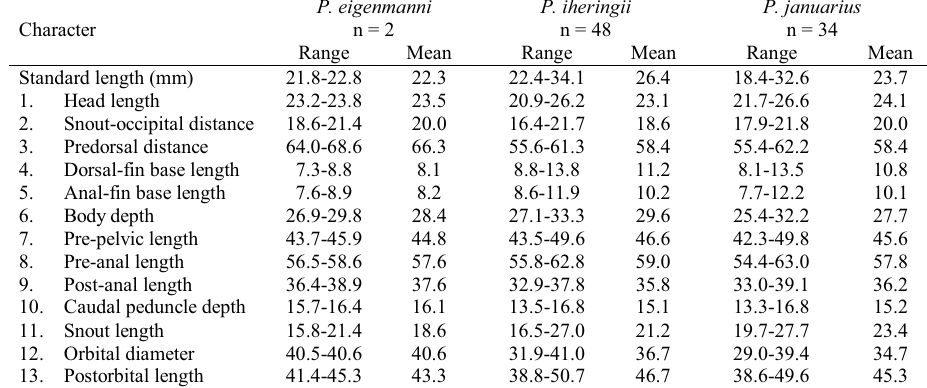
Table 2. Descriptive morphometrics of females of Phalloptychus species. Measurements 1-10 are percents of standard length and measurements 11-13 are percents of head